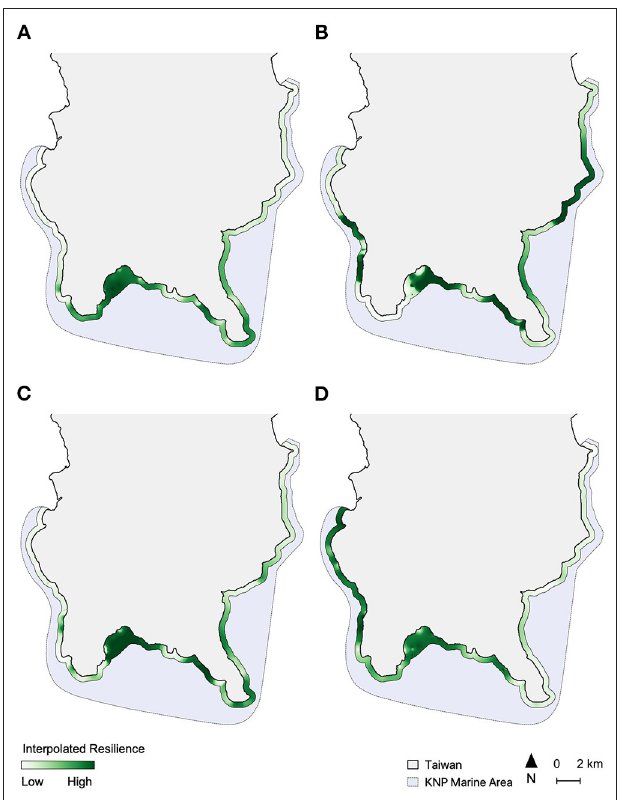
FIGURE 2 | Spatial interpolation of relative resilience scores along a 500-m coastal buffer from each of the four assessments, including (A) Assessment 1; (B) Assessment 2; (C) Assessment 3, and (D) Assessment 4. Resilience score scales are relative for each map and colored on a quantile scale.